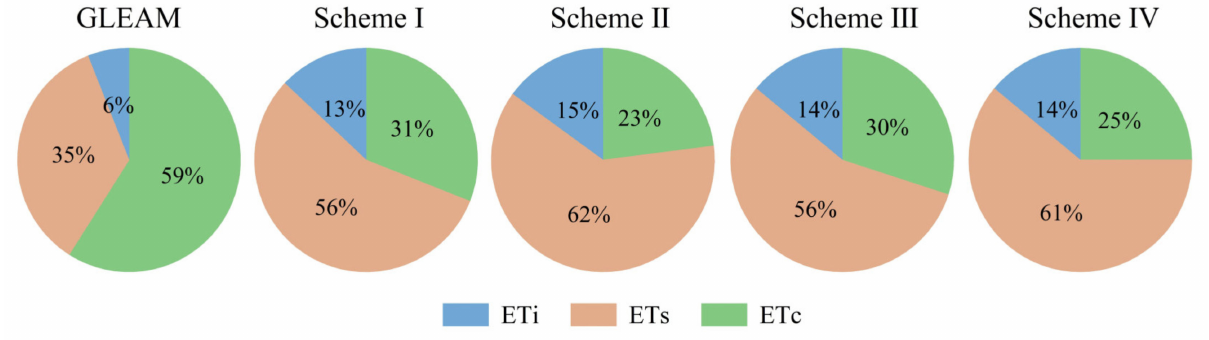
Figure 10. Pie charts illustrate the national average contribution of each component to total ET for GLEAM and PT-JPL model. ET i : Interception evaporation; ET s : Soil evaporation; ET c : Canopy